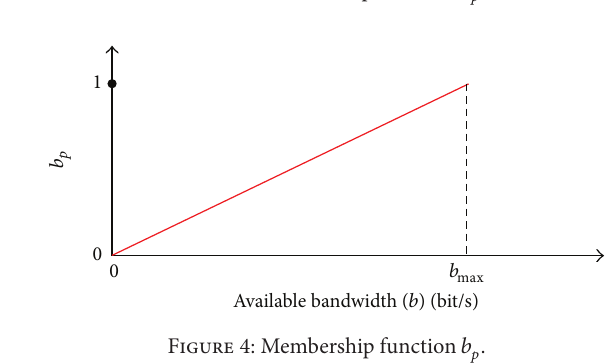
Figure 3: Membership function 𝑎 𝑝 .